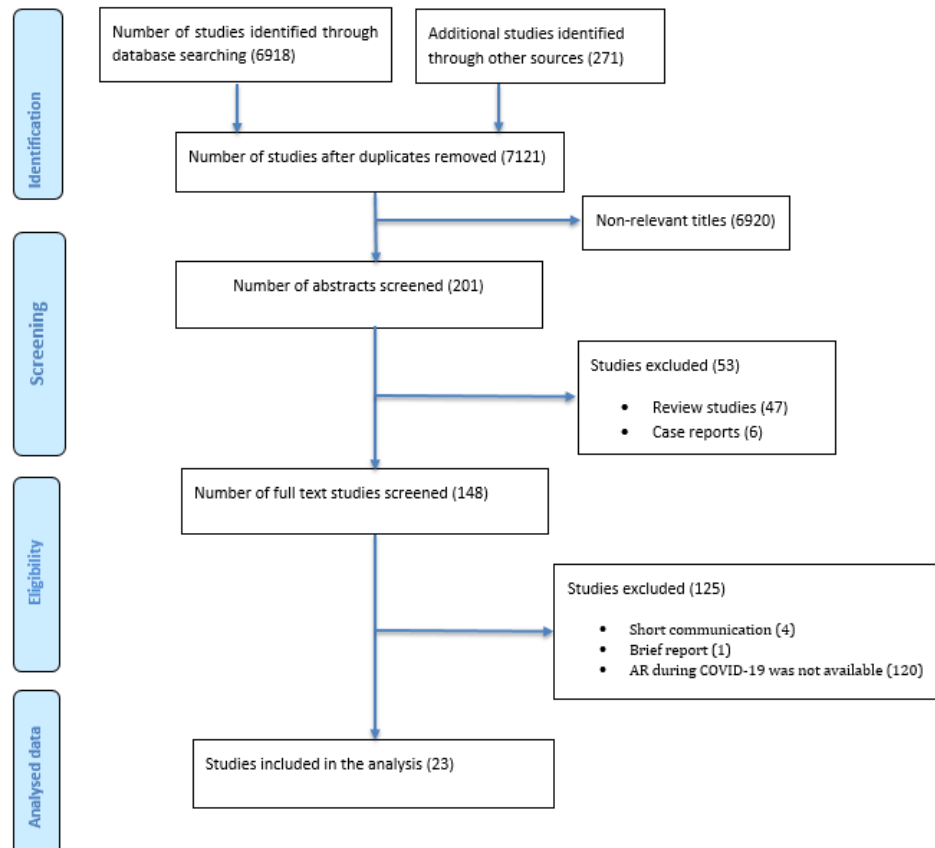
Figure 1. PRISMA flowchart of the systematic search.